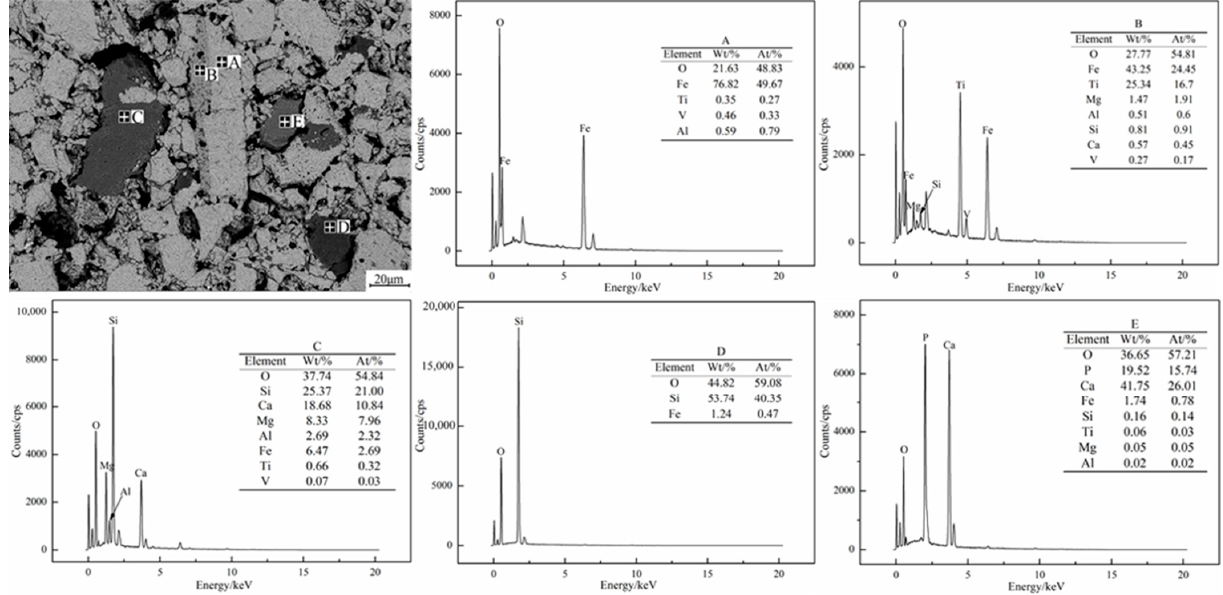
Figure 10. Energy dispersive spectrometer (EDS) graph of oxidized pellets with 40% sea sand ore.